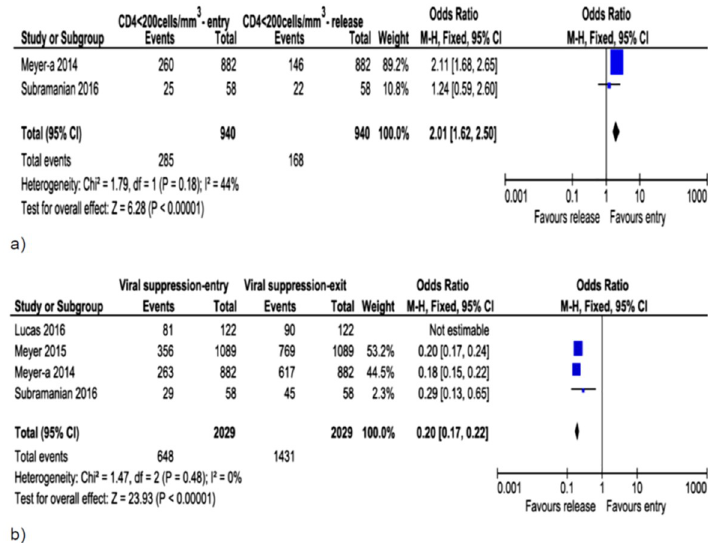
Fig 5. Forest plot of differences in CD4 count (a) and viral suppression (b) at prison entry and exit. Higher odds of low CD4 count (CD4 < 200cells/mm 3 ) and viral non-suppression at entry than at exit from prison.